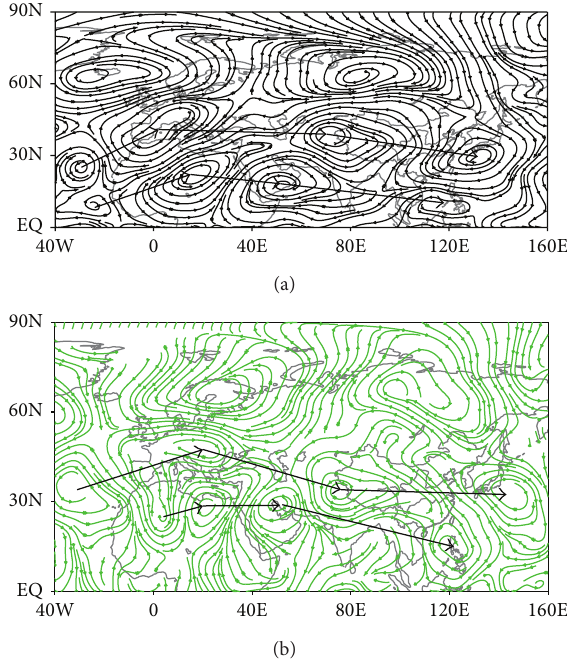
Figure 5: 500 hPa stream field departure from January 11 to 30, 2008 (a), and correlation analysis between plateau surface heating anomaly and 500 hPa stream anomaly